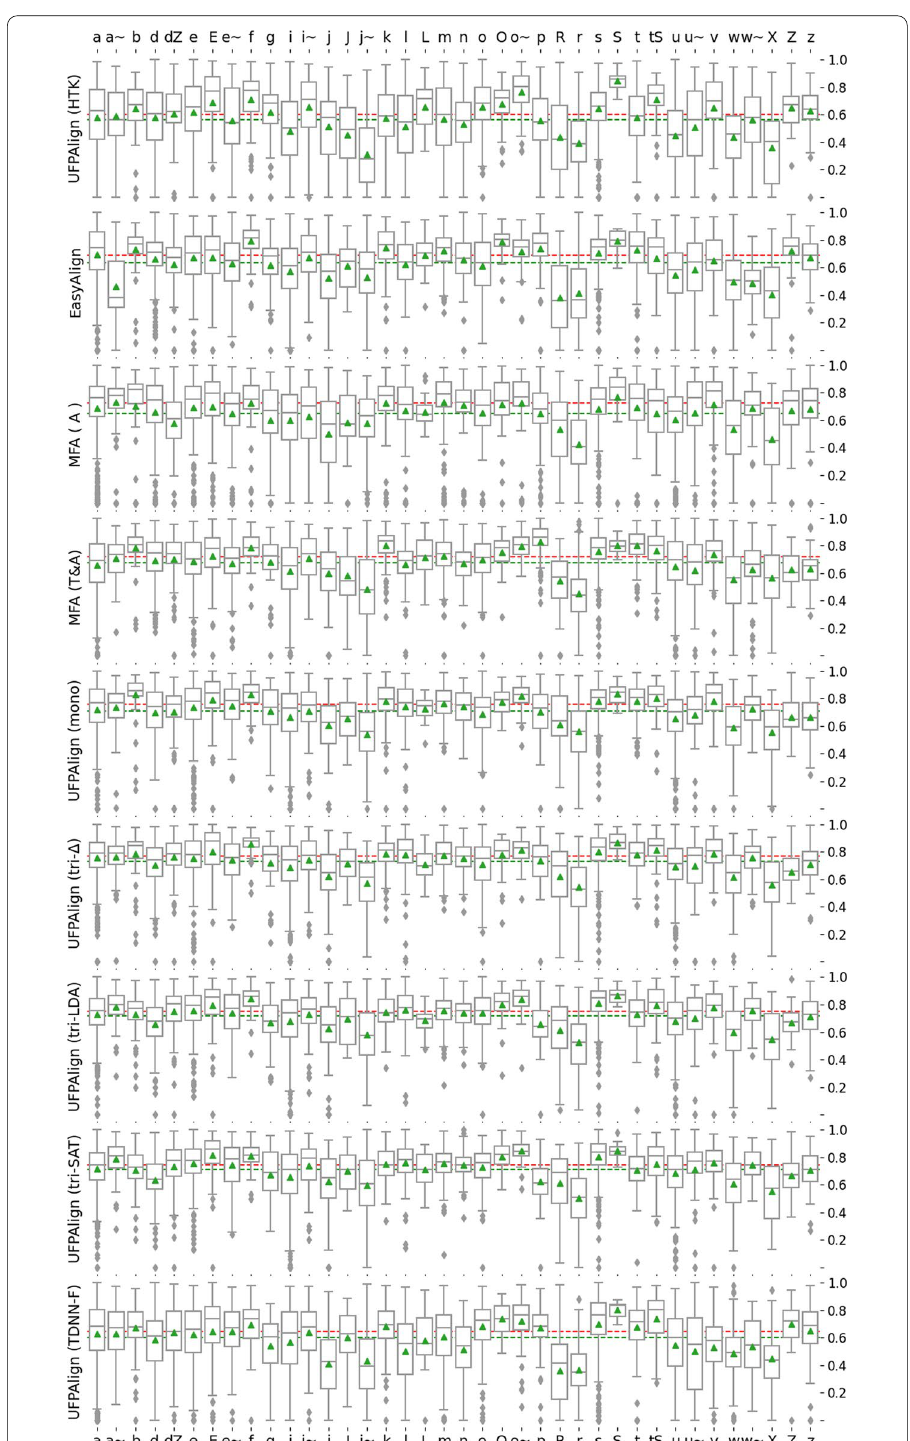
Fig. 12 IoU values per phoneme on the utterances of the female